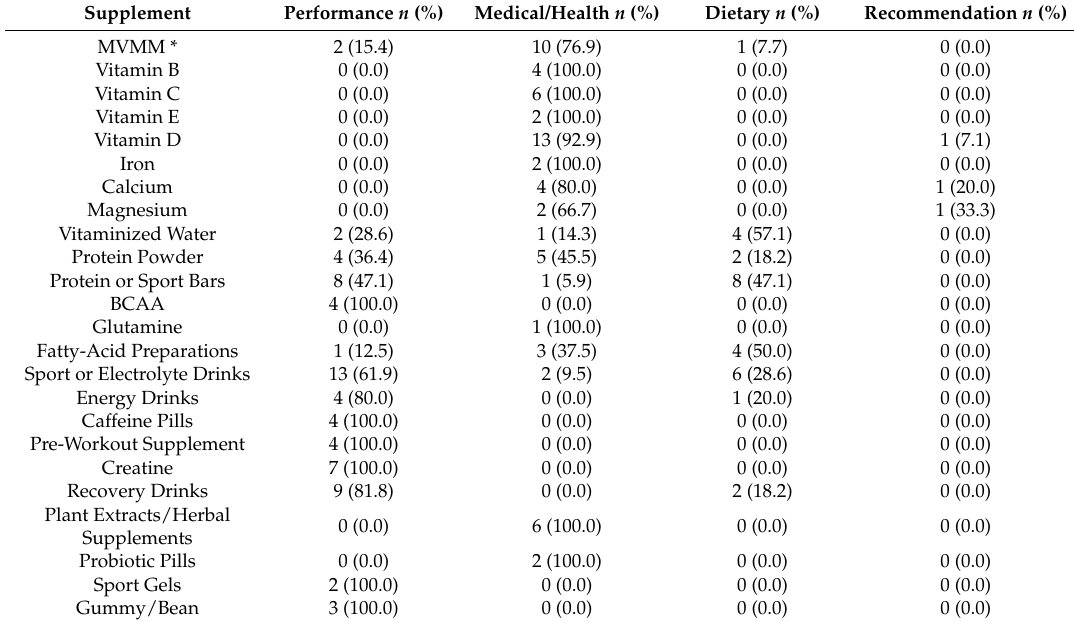
Table 3. Supplement Reason Frequencies.